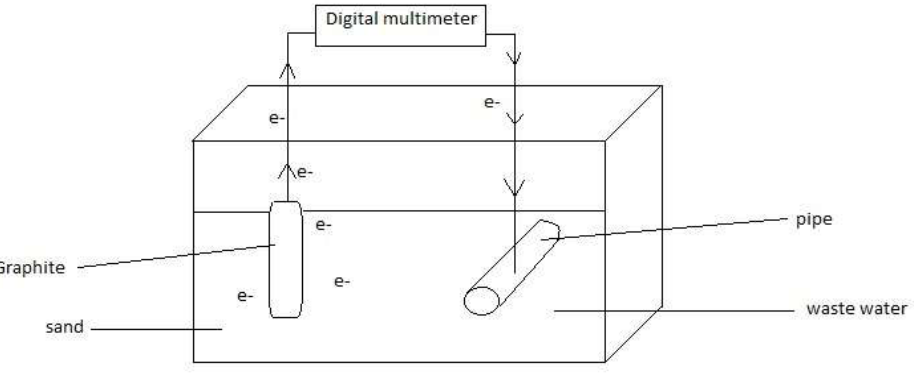
Figure 1: Schematic diagram of the experimental biological CP